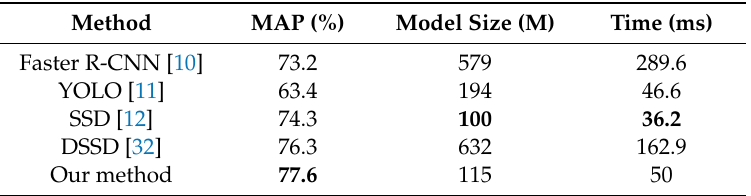
Table 2. Comparisons of the model size and elapsed time on the PASCAL VOC